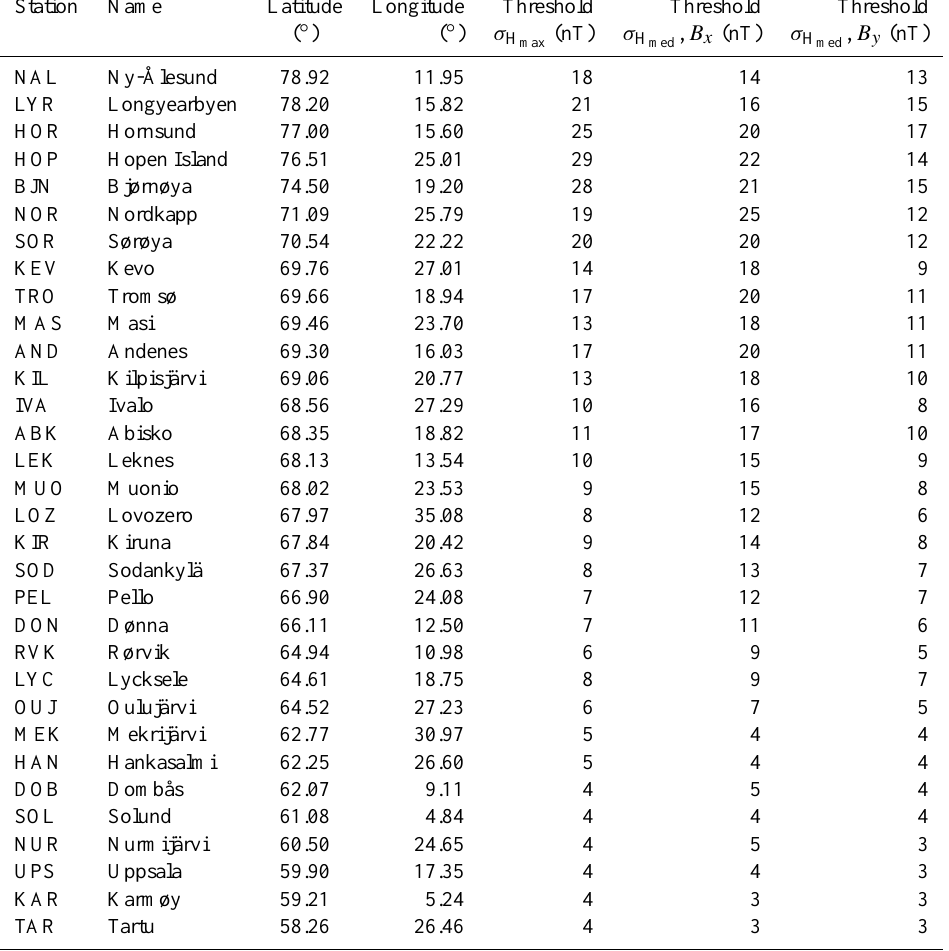
for each IMAGE station. med